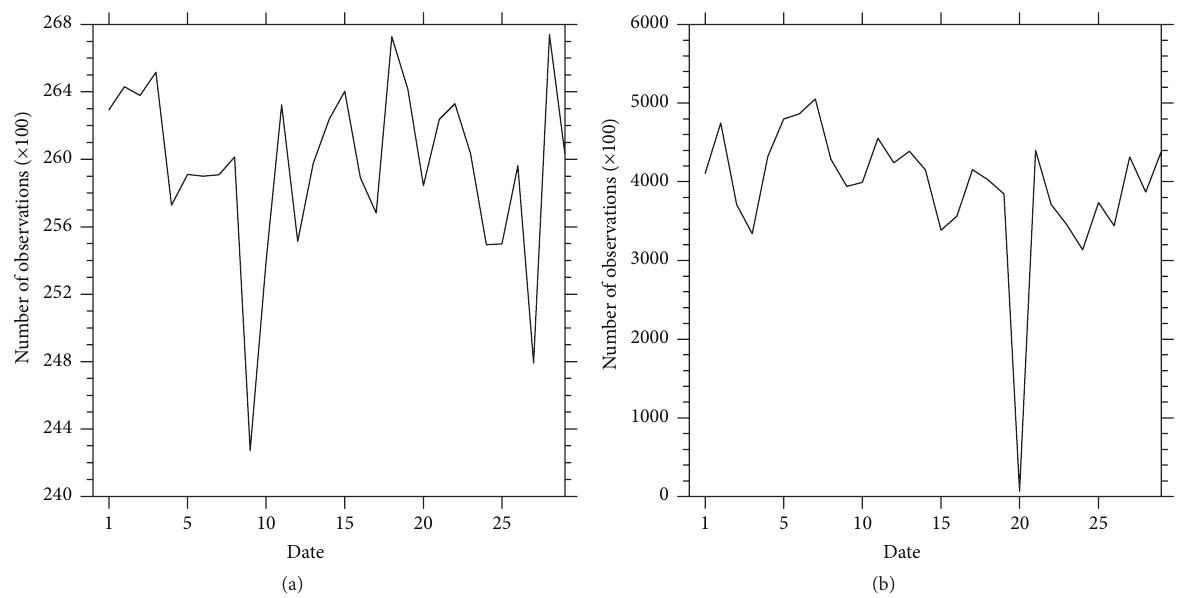
Figure 2: Time series of the number of (a) Radiosonde and (b) AMSU observations assimilated in 00 UTC data assimilation cycle from 1 to 30 January,